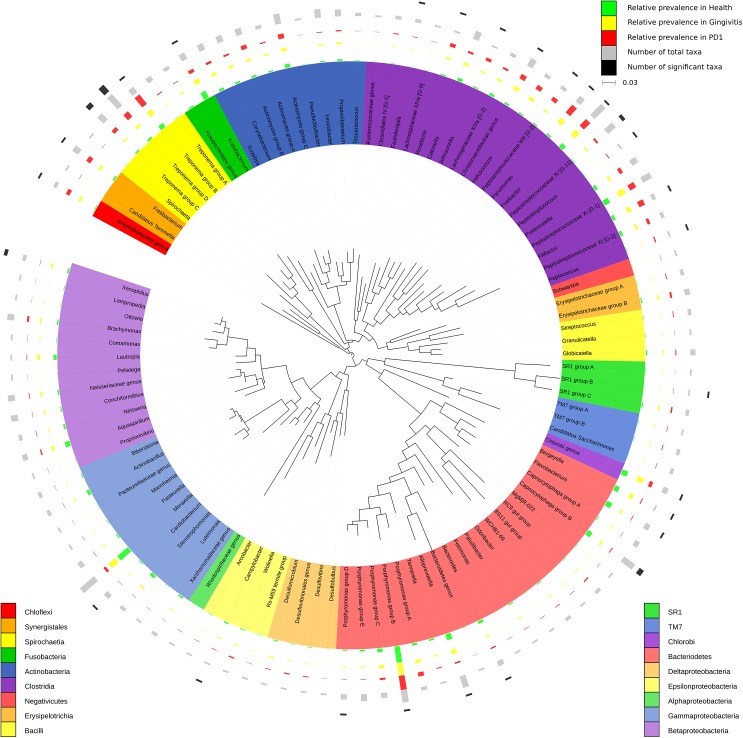
Circular maximum likelihood tree of full length 16S rRNA genes at the genus level.The inner band shows genera coloured by phylum/class (based on NCBI taxonomy). The next three bands depict relative abundance of each genus in health (green), gingivitis (yellow) and mild periodontitis (red). The two outer bands show the total number of taxa identified within the genus (grey, ranging from 1 to 11) and number of those taxa that showed a significant association with a health status (black, ranging from 0 to 5). A species level representation of the figure is given in S1 Fig.